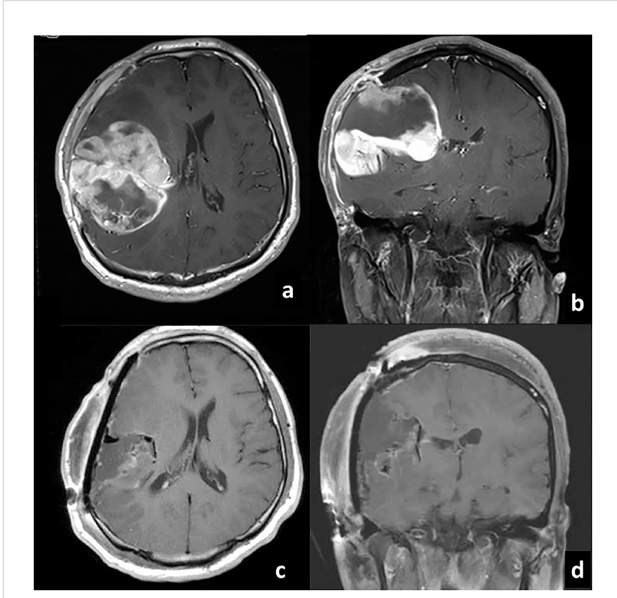
FIGURE 1 Gadolinium-enhanced T1-weighted MRI before (A) axial, (B) coronal and after (C) axial, (D) coronal) gross total resection of glioblastoma at our